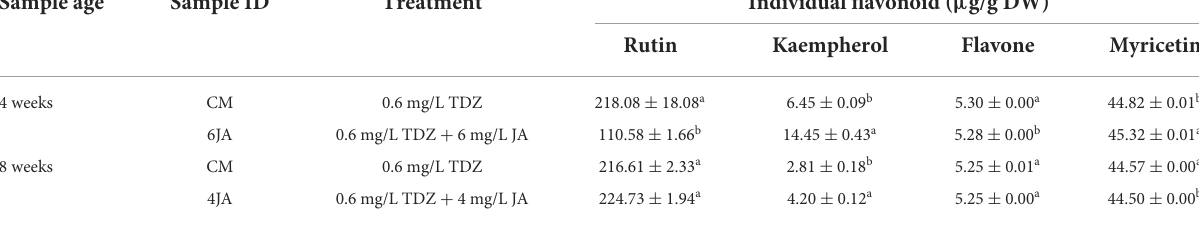
TABLE 4 Distribution and amount of individual flavonoids present in 4-week-old green callus of A. indica